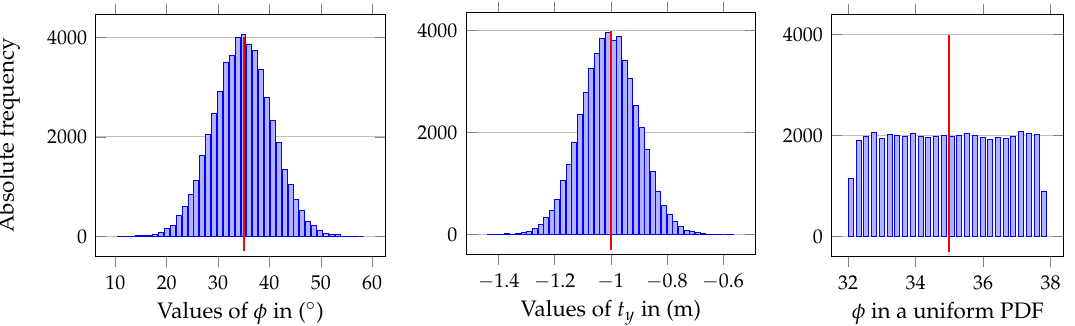
Figure 6. Histogram of variables φ and t y , with mean value marked, and, respectively, σ φ = 4.8 ◦ and = 0.08m when the original Gaussian uncertainty is 5.7 ◦ and 0.1m. The third histogram on the right σ t y shows the final PDF of φ when the uncertainty is uniform, but now with σ φ = 1.36 ◦